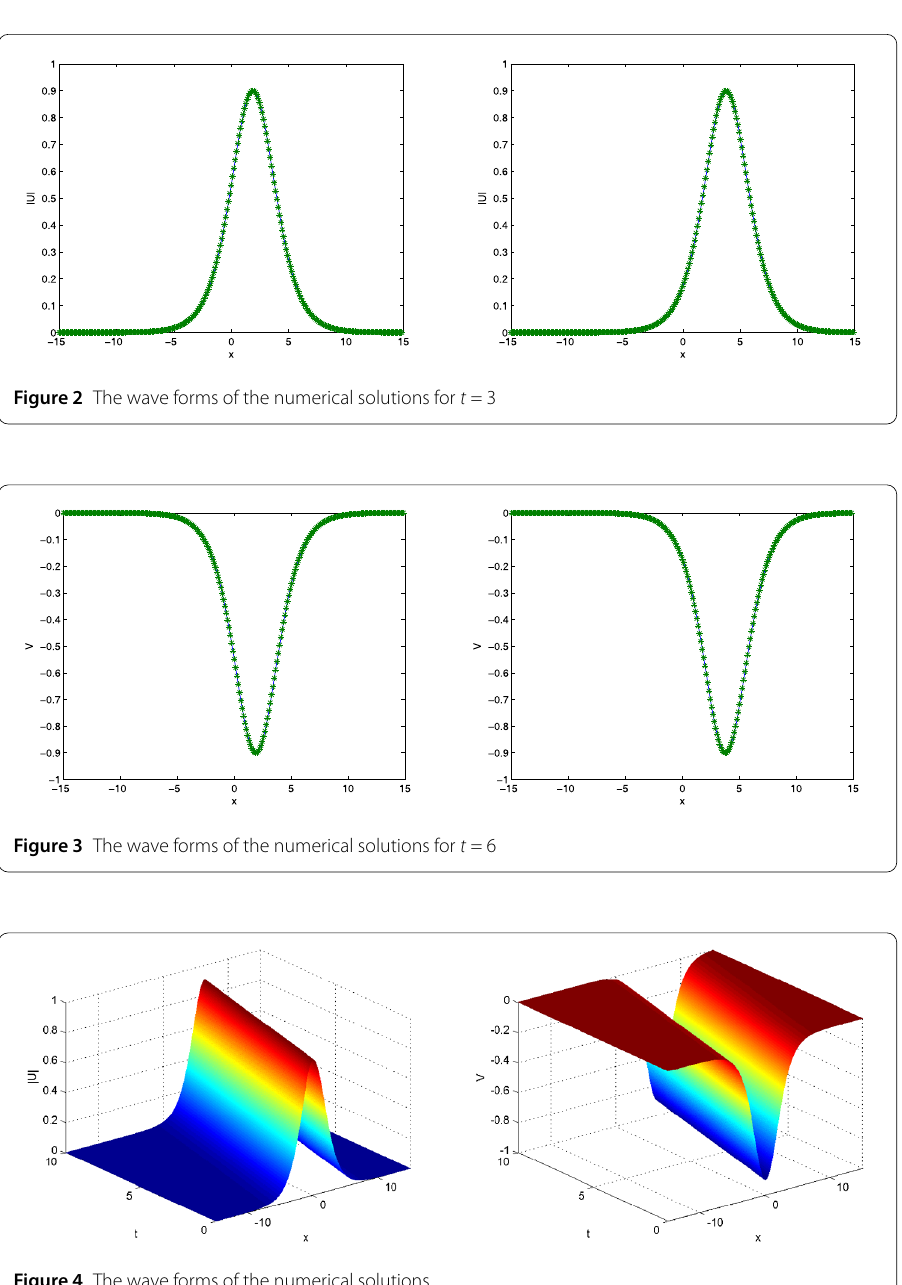
Figure 4 The wave forms of the numerical